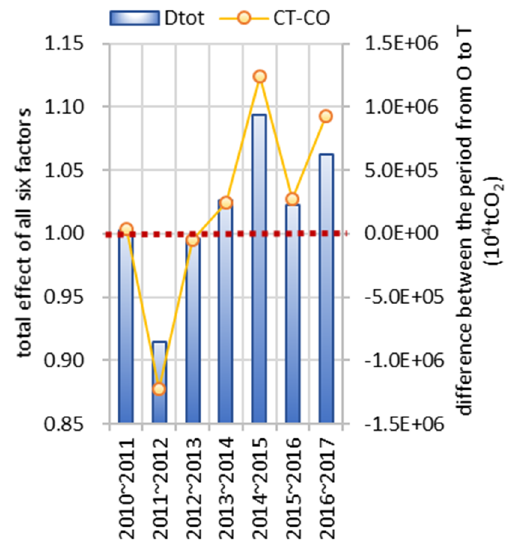
Figure 2. Comparison of the changes in D tot and CO 2 emissions. D tot : the total effect of six driving factors.